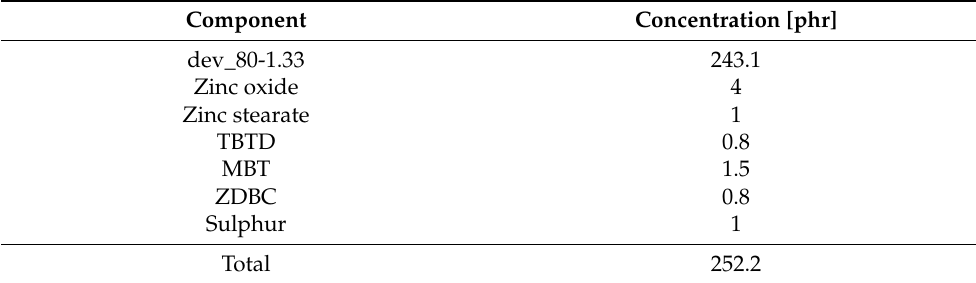
Table 3. Composition of dev_80-1.33_mix.